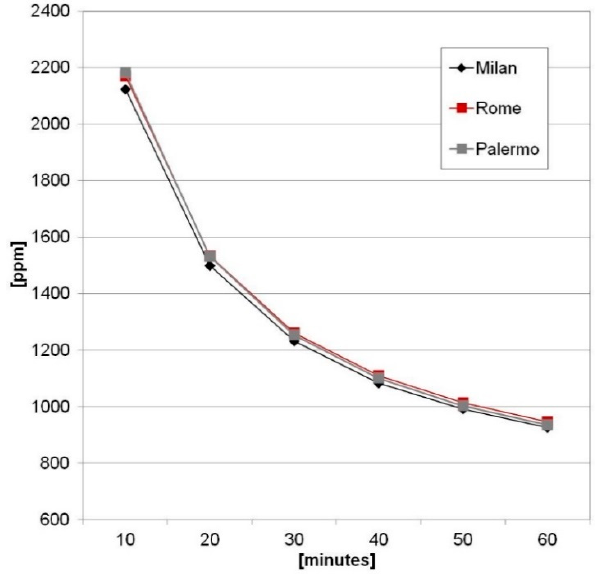
Figure 9. Average CO 2 concentration versus window opening period per hour for the NZEB with external shading devices and the south-oriented classroom.